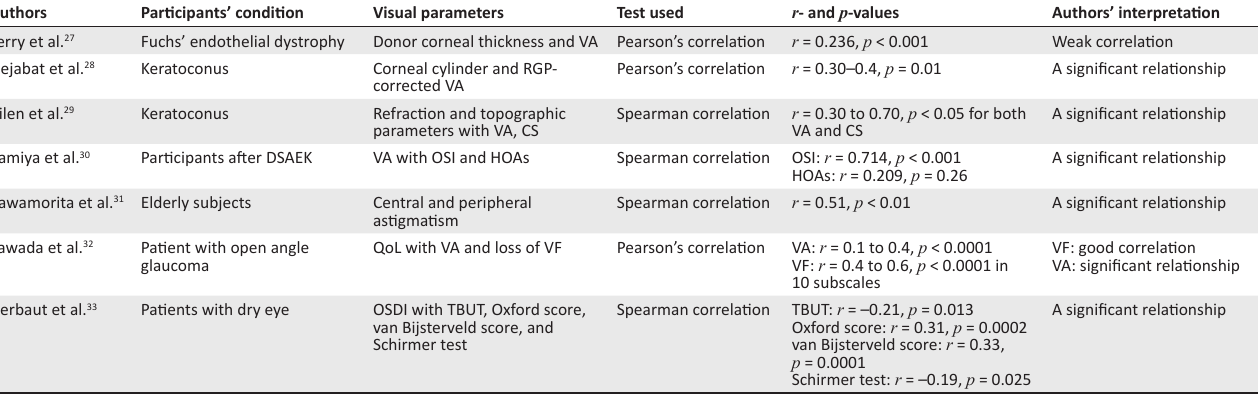
TABLE 1: Review of some studies investigating factors that could influence visual acuity, contrast sensitivity and dry eye disease using both Pearson’s and Spearman’s correlation coefficients. Authors